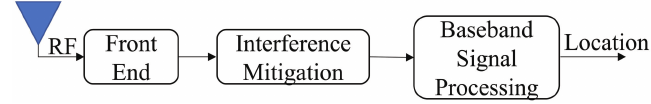
Figure 3. The structure of the train positioning